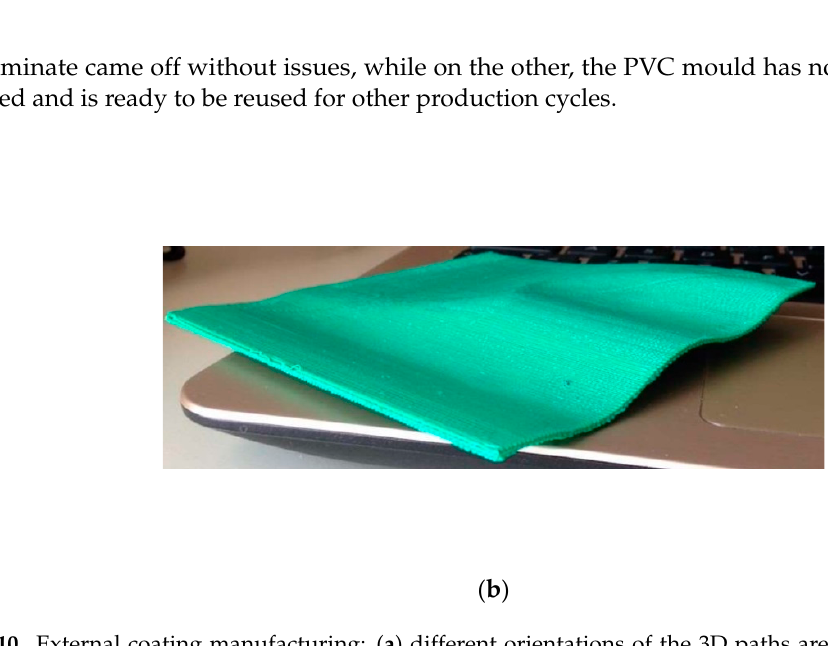
Figure 12. Large ‐ scale mould finishing: ( a ) rough milling to remove exceeding external clay; ( b ) accurate milling for surface finishing.